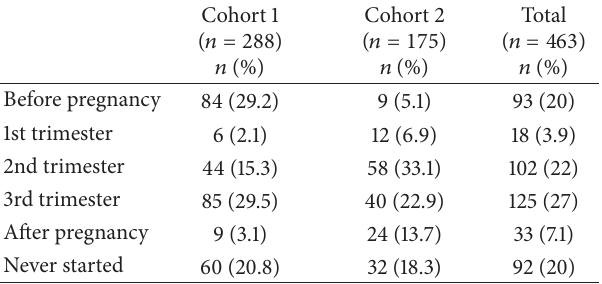
Table 2: Timing of ART initiation based on change in guidelines in June 2011 ∗